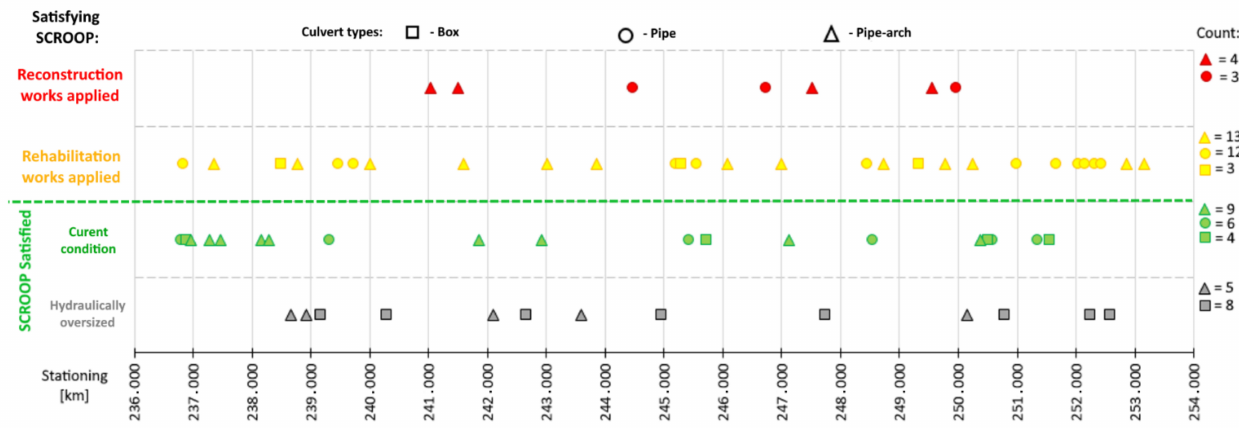
Figure 12. Summary of results of the CMOOP algorithm application for all culverts on the analyzed road section between Raška and Novi